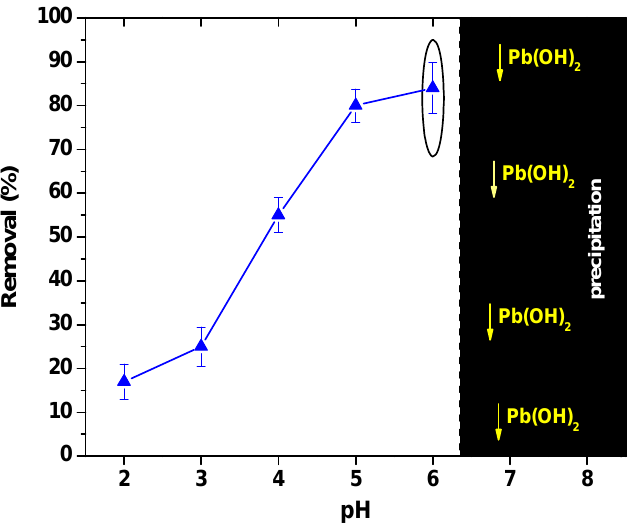
Figure 2. Effect of pH on Pb(II) adsorption by PAC.